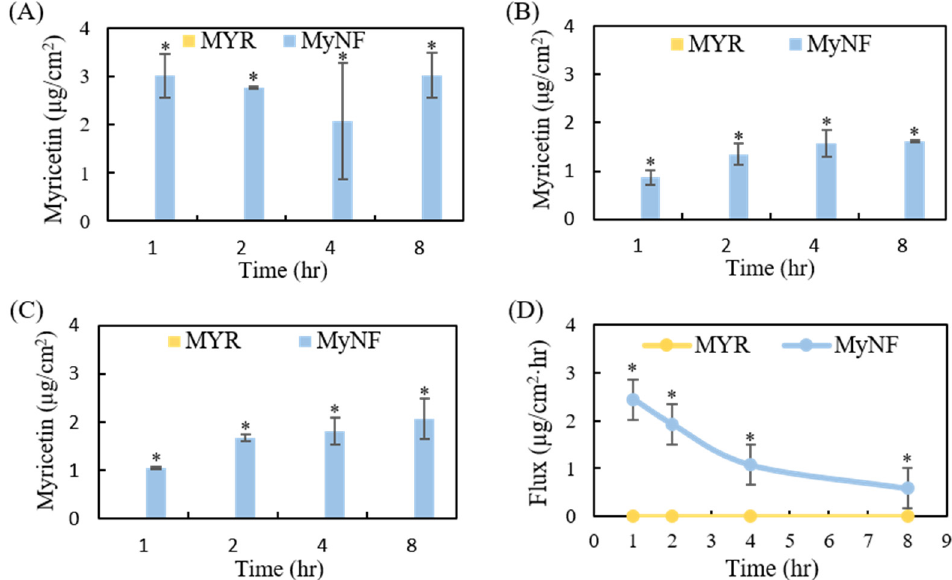
Figure 8. In vitro percutaneous penetration of MYR and MyNF: ( A ) stratum corneum, ( B ) epidermis, ( C ) dermis, and ( D ) flux of MYR and MyNF. The values represent the mean ± SD ( n = 5). * p < 0.05 indicated a statistically significant difference compared with MYR.